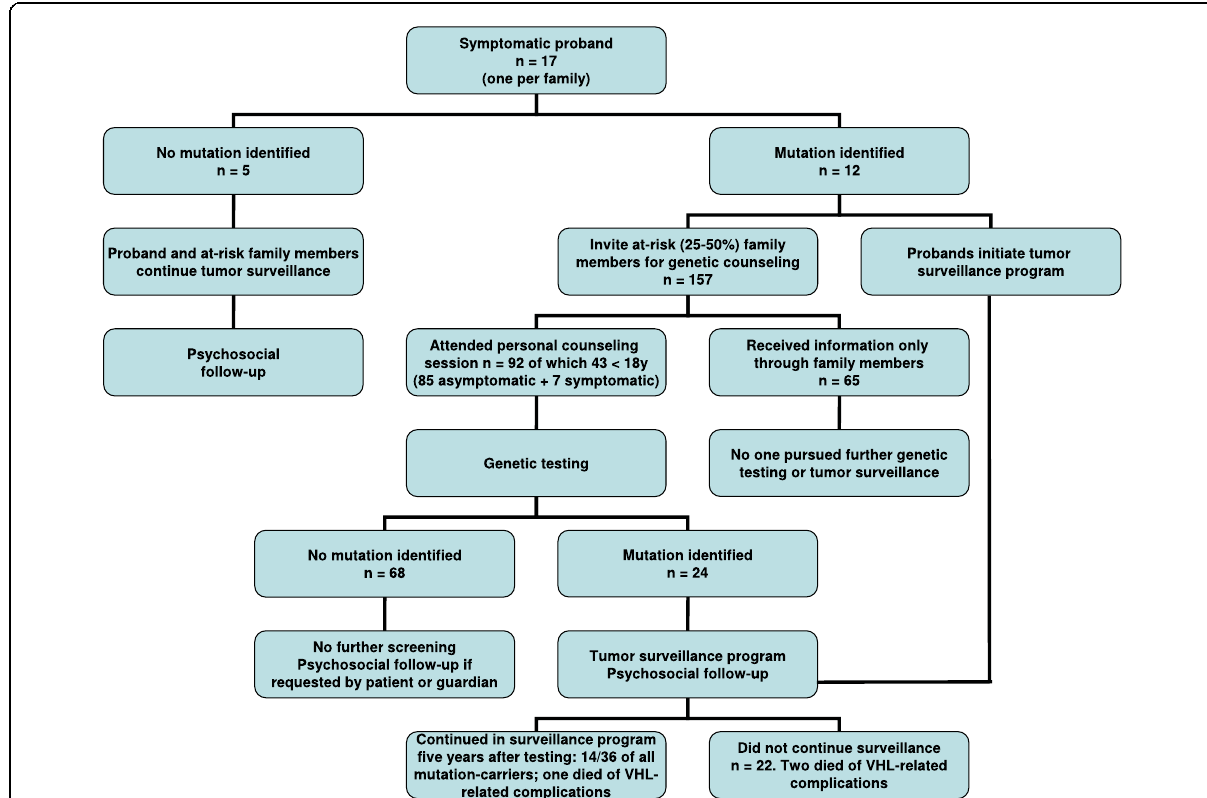
Figure 2 Uptake of predictive testing in our cohort of 17 families with VHL